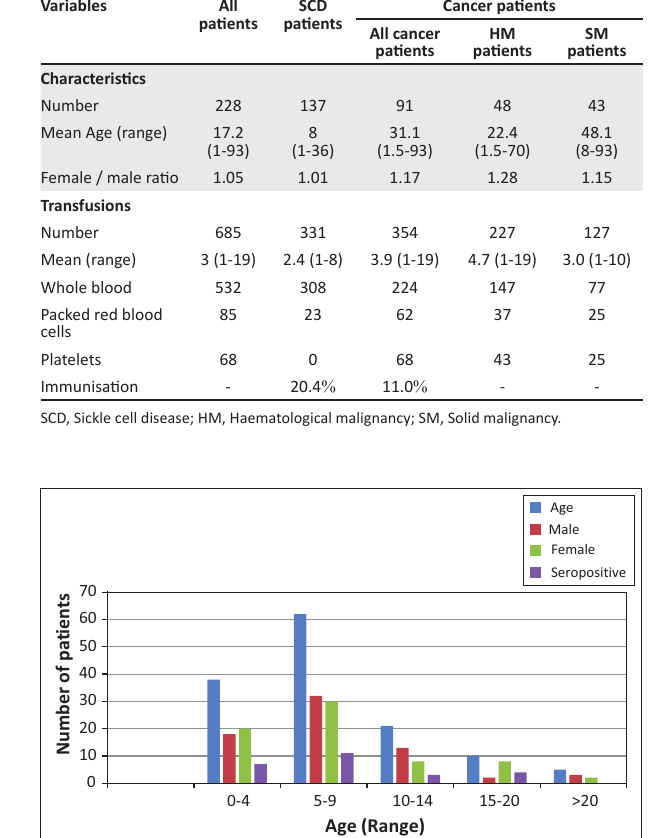
TABLE 1: Characteristics of transfused sickle cell disease and cancer patients at Kenyatta National Hospital, Nairobi, Kenya, 2014. Variables